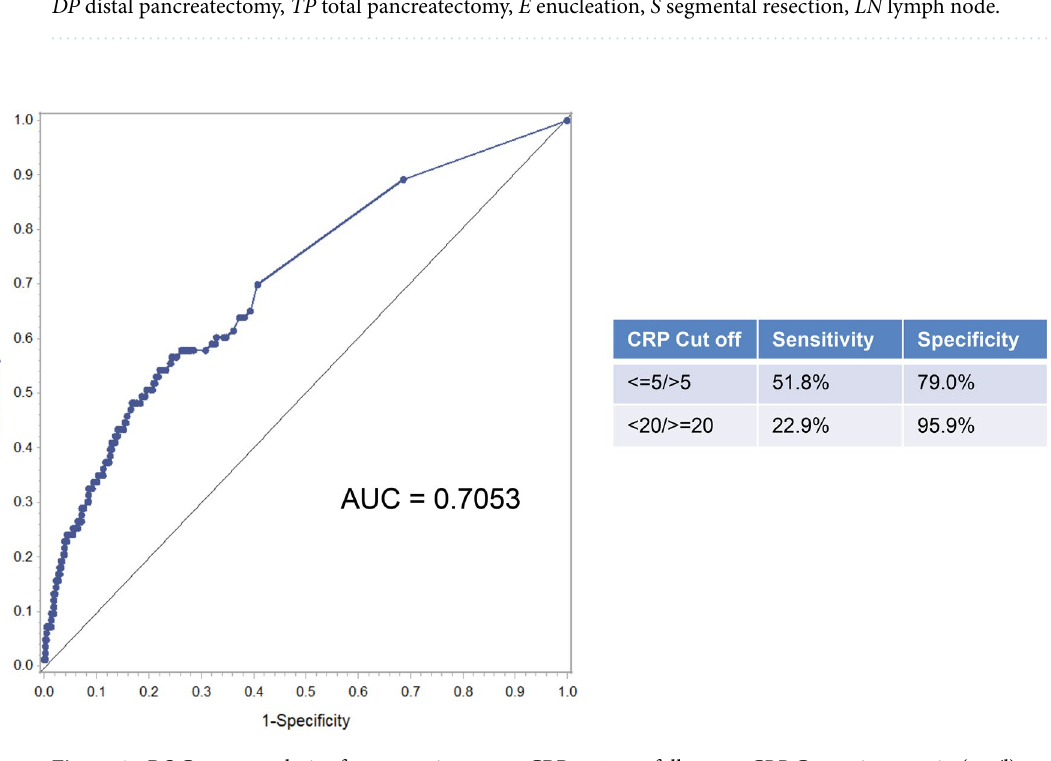
Figure 4. ROC curve analysis of preoperative serum CRP at 5 year follow-up. CRP C-reactive protein (mg/l), ROC receiver operating characteristic, AUC area under